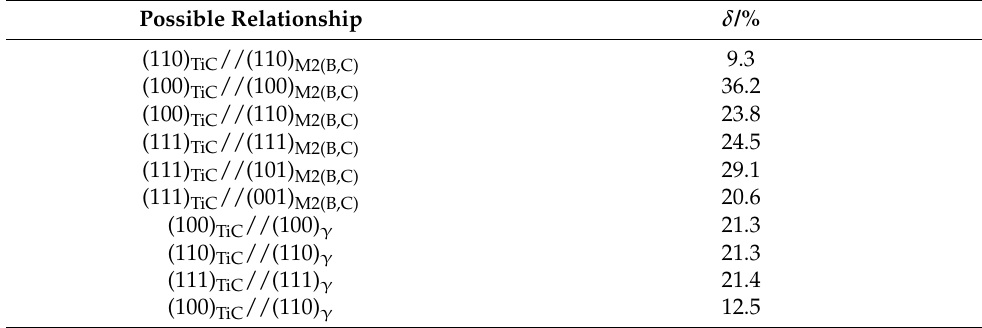
Table 6. Calculated results of misfit degree.